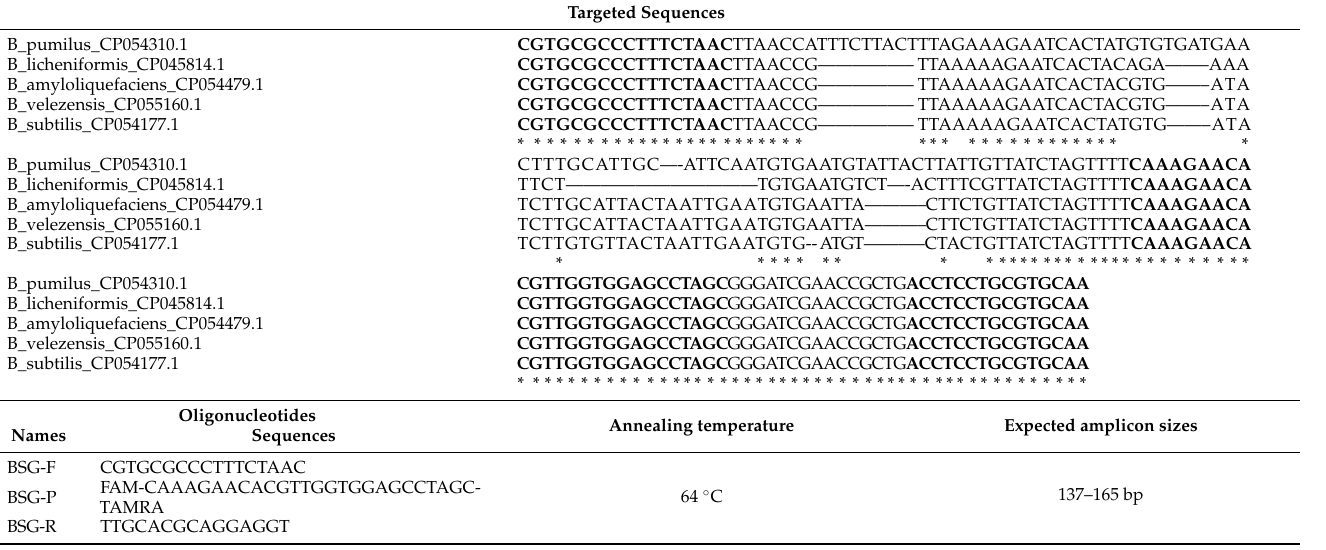
Table 1. Oligonucleotides of the real-time PCR BSG method targeting bacterial species belonging to B. subtilis group that are used to produce microbial fermentation products. On the targeted sequences, the location of the used oligonucleotides is indicated in bold. Targeted